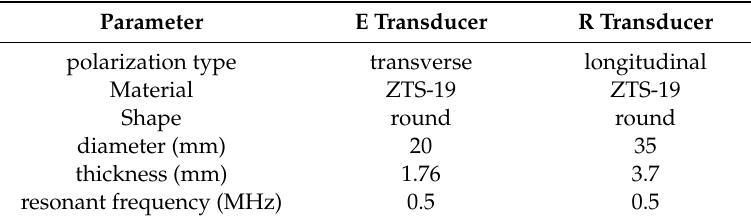
Table 3. Parameters of emitting and receiving transducers.